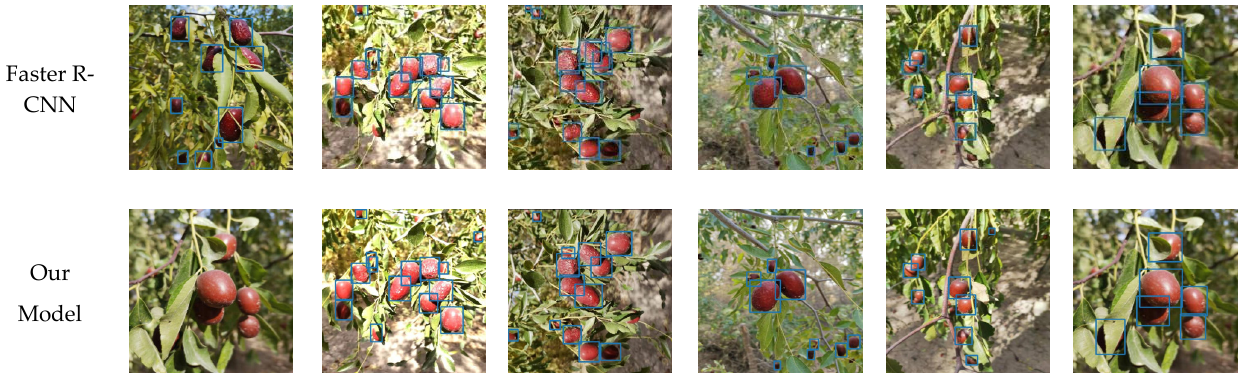
Figure 14. Test results of different algorithms. Where the blue boxes are the test results of model test. According to the experimental results, In the detection of red jujube,